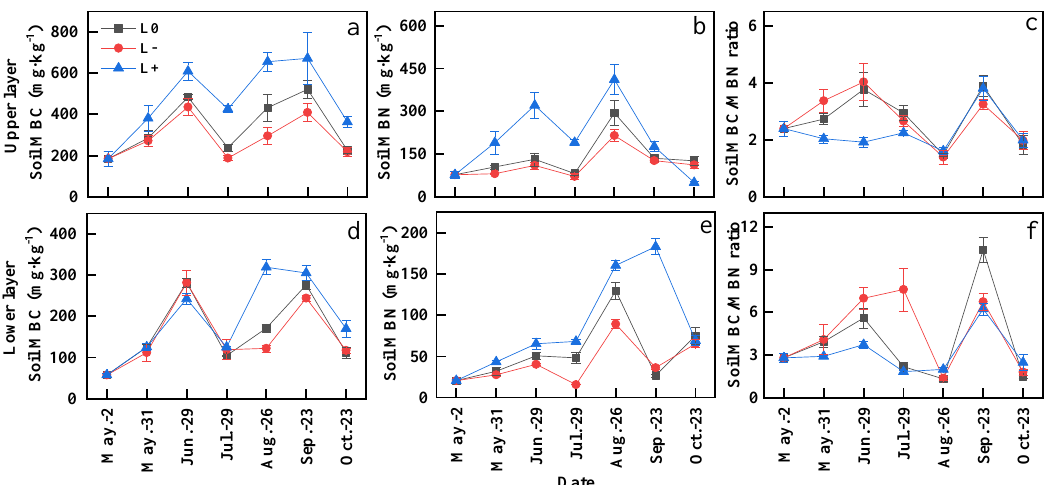
Figure 5. Monthly dynamics of the contents of soil MBC, MBN, and MBC/MBN ratio of different litter manipulation in varied soil layers of the Larix gmelinii forest ( n = 9).